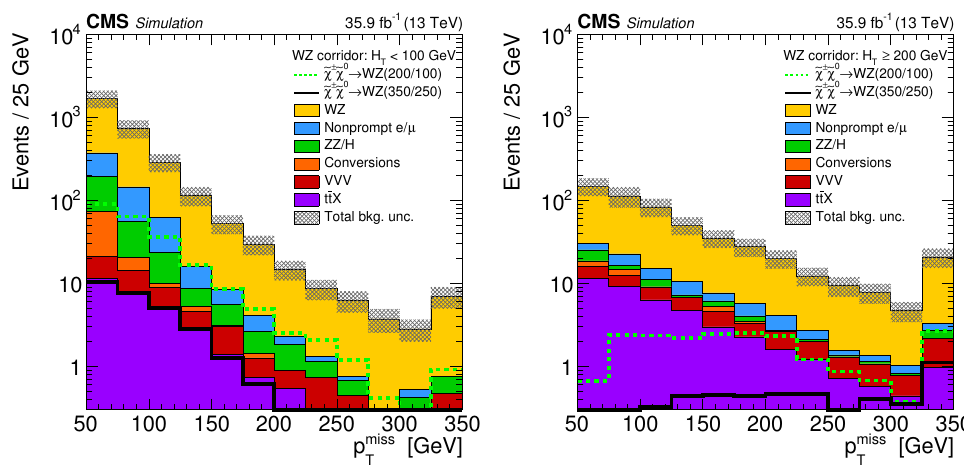
Figure 4 . Distributions of p miss as the expected SM background for H T < 100 (left) and (cid:21) 200 GeV (right). The mass values for the signal points are given as ( m between signal and background becomes more pronounced due to the presence of large Lorentz